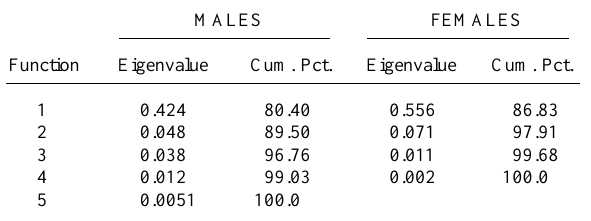
Table VII - Results of the canonical analysis of the characterized groups (see legend to Figure